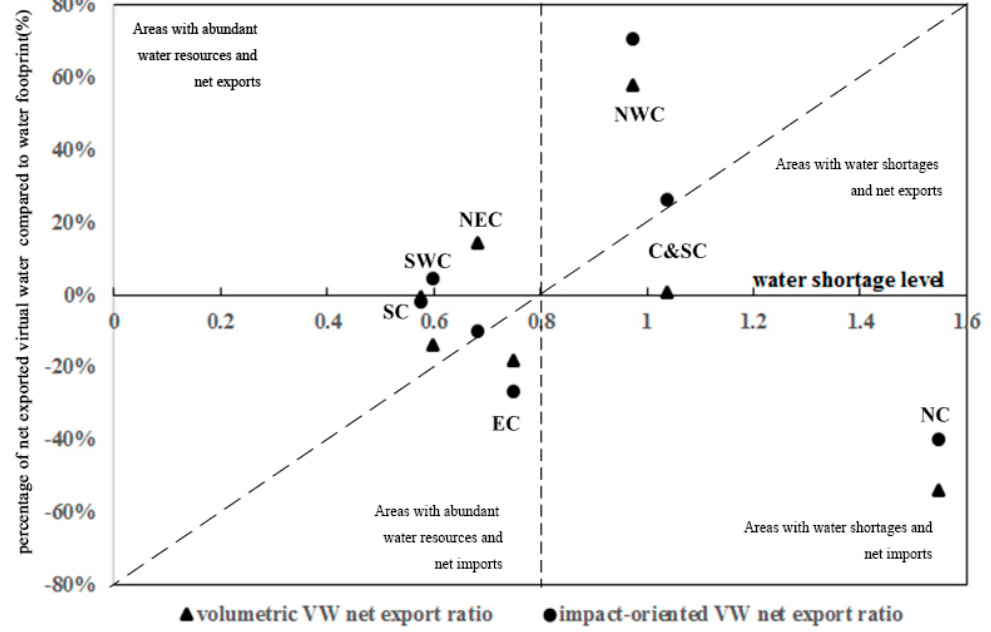
Figure 4. The percentage of net exported virtual water compared to water footprint and the regional water shortage level.